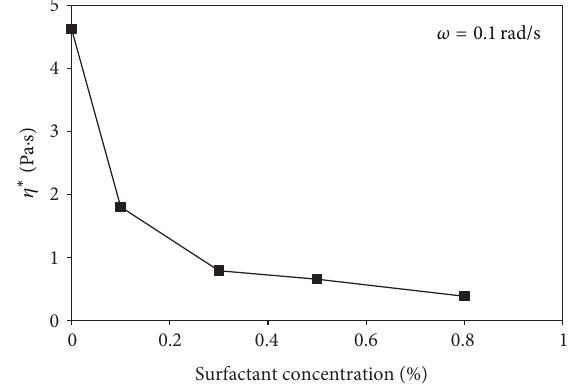
Figure 2: Effect of surfactant concentration on complex viscosity of copolymer in deionized water at 50 ∘ C.